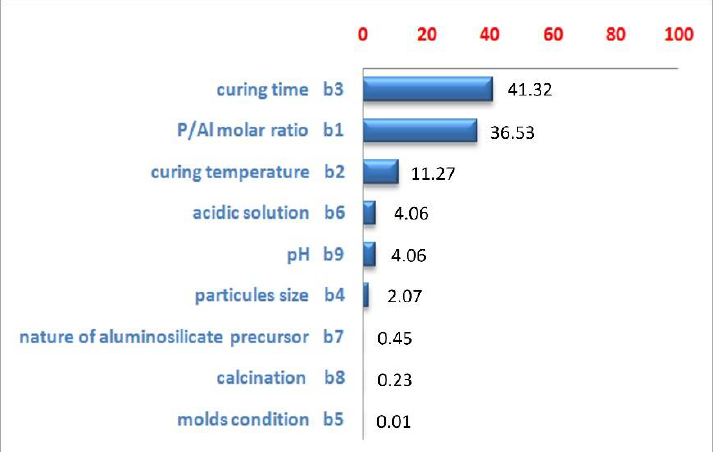
Figure 4. Pareto diagram of Plackett – Burman design.